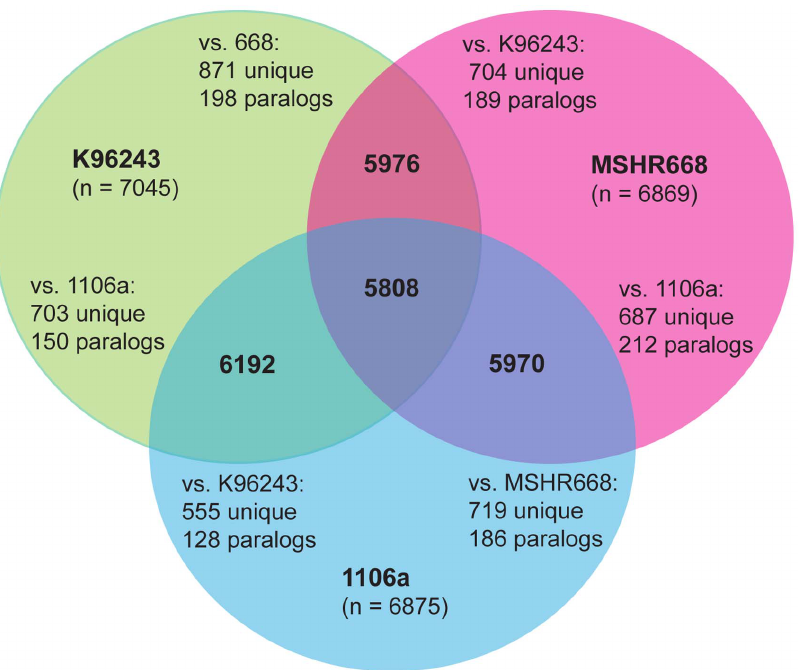
Fig. 2. Venn diagram illustrating the numbers of CDS shared by B. pseudomallei strains K96243, MSHR668 and 1106a, determined by a bidirectional best BLAST hits analysis. The number of CDS unique to each genome in each pairwise comparison and the number of putative paralogs are shown. The total number of CDS present in each genome is given below the genome name.